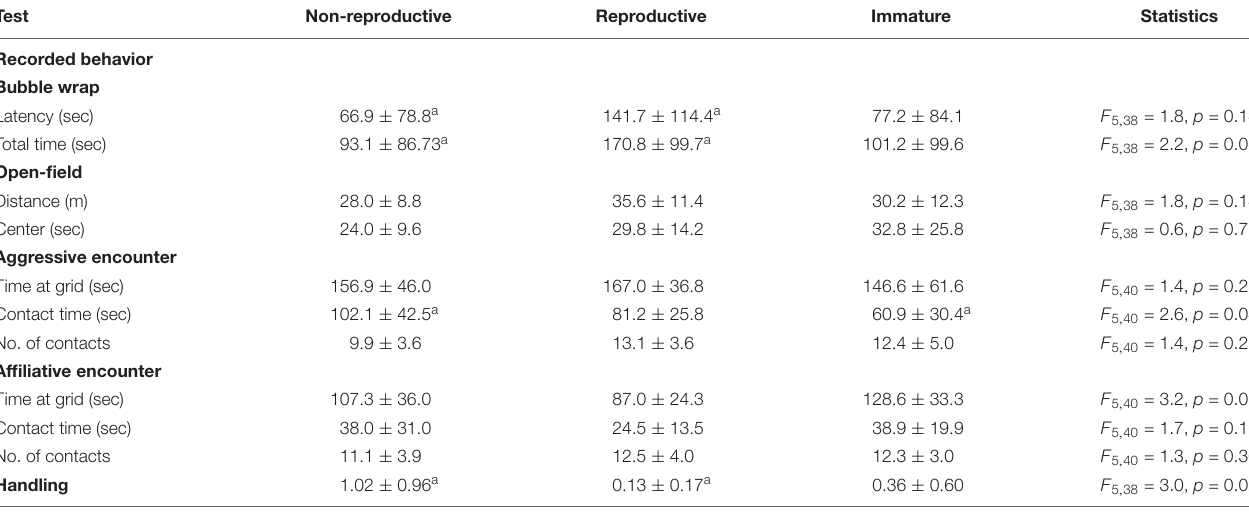
TABLE 3 | Mean values ± SD of 11 behaviors recorded in five tests for the three status groups (non-reproductive adults, reproductive adults, and